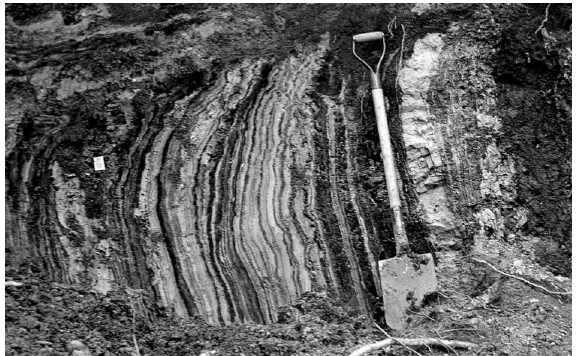
Fig. 8. Sandstone with graptolite argillite interlayers of the Pakerort Regional Stage on the western side of Tornim(cid:228)gi Hill. The topmost part is inclined towards the direction of the glacier movement and covered with stratified lodgement till. Photo by A. Raukas.